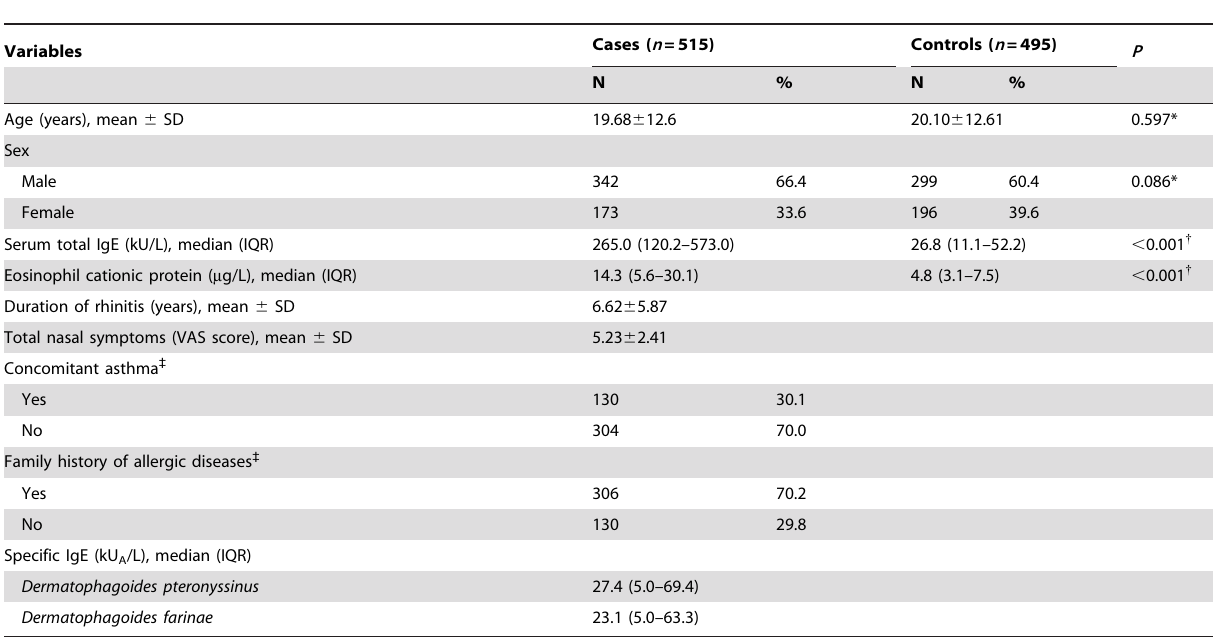
Table 2. Distribution of selected variables among cases and